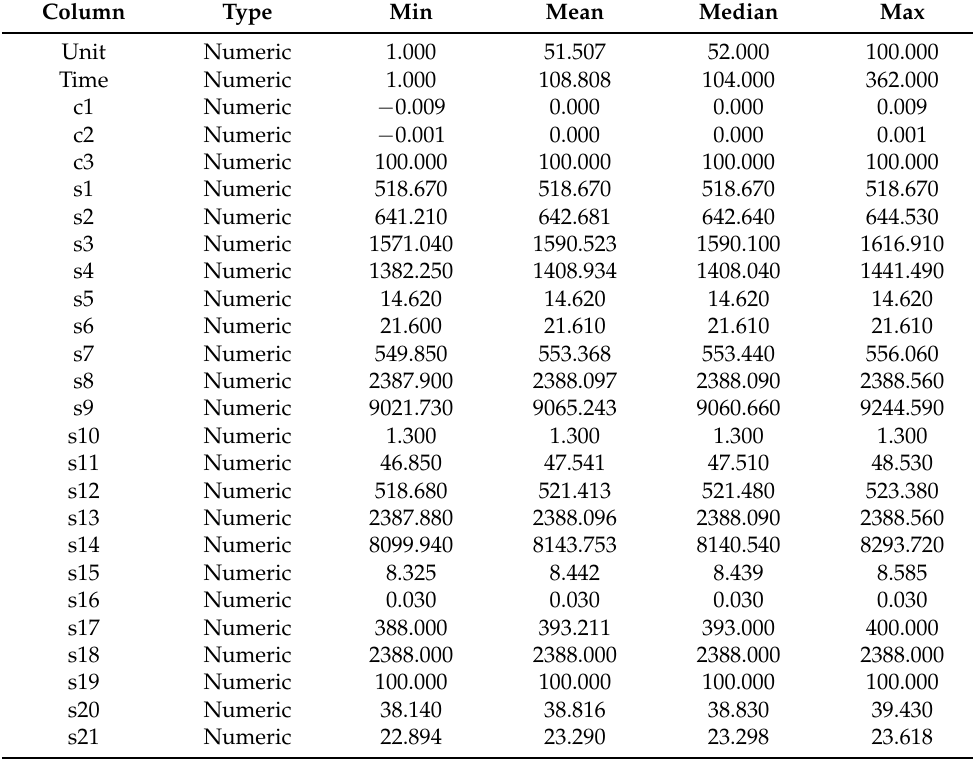
Figure 16. Visualisation of a sample of data from [18]. Table 2 contains parameters of every column in the dataset. Table 2. Statistical description of test data